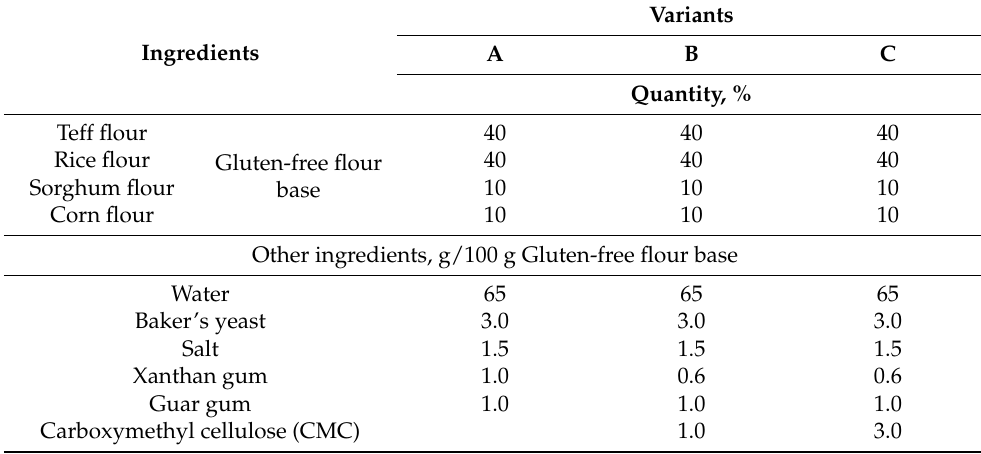
Table 1. Composition of gluten-free bread formulations.